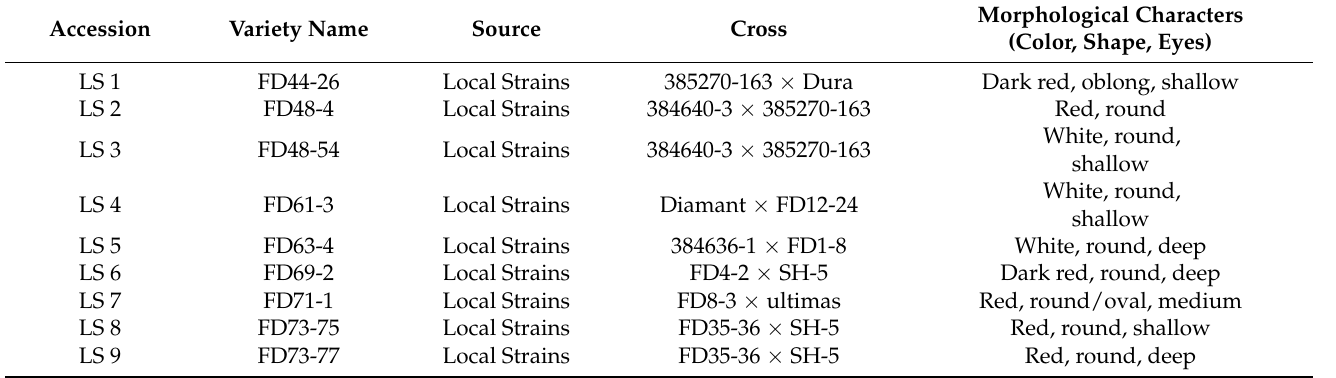
Table 1. Details of 80 potato ( Solanum tuberosum L.) genotypes collected from the Potato Research Institute Sahiwal used for genetic diversity analysis in this